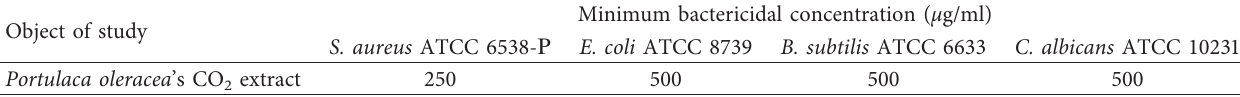
Table 4: The results of the antimicrobial activity of Portulaca oleracea ’s CO Object of study